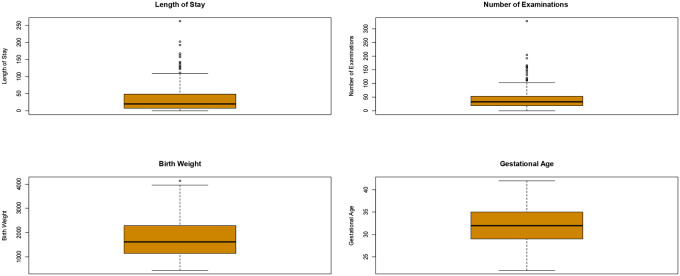
Sample variability.